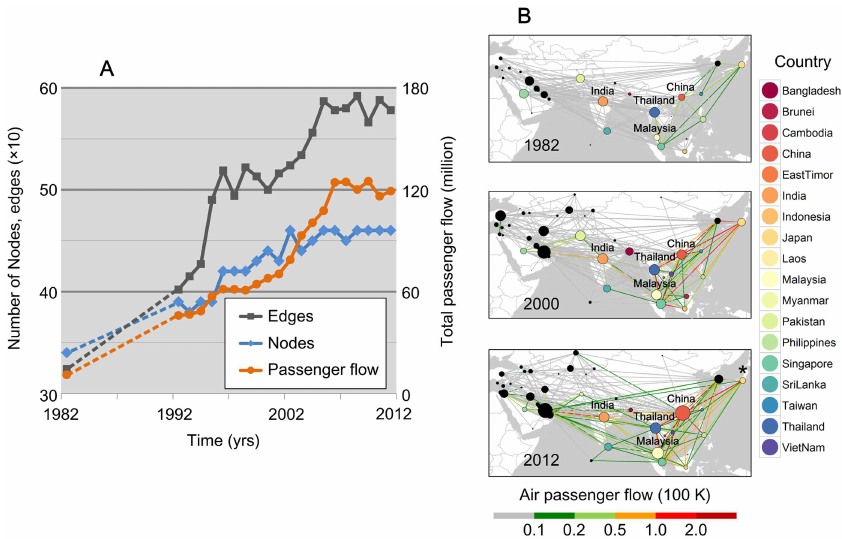
Fig 2. Growing airline networks in Asia. (A) Number of nodes(countries belongingto the Asian air transport network), the number of airlines, and total passengerflow in the Asian air transport network between 1982–2012. Records are not availablefor the period 1983–1991, so dashedlines represented imputed missing values obtainedby linear interpolation. (B) Passenger flux in Asia in 1982, 2000 and 2012. The size of each node correspondsto the degreecentrality of the country in the airlinenetwork. Color coded lines representthe volume of air passengerflux. Node colors correspond to the countries indicatedon the right- hand side of the figure. Black points indicatecountriesfor which no virus sequencewas includedin the geneticanalyses. Chinashares one of the busiest Asian flight routes with Japan, which is indicatedby an